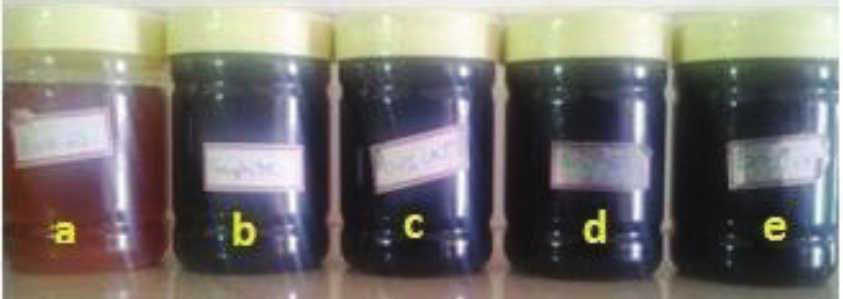
Figure 2: (a) Mineral oil, (b) mineral oil + 0.5% wt graphite, (c) mineral oil + 0.1% wt MWNT, (d) mineral oil + 0.5% wt MWNT, and (e) mineral oil + 0.6% wt MWNT.